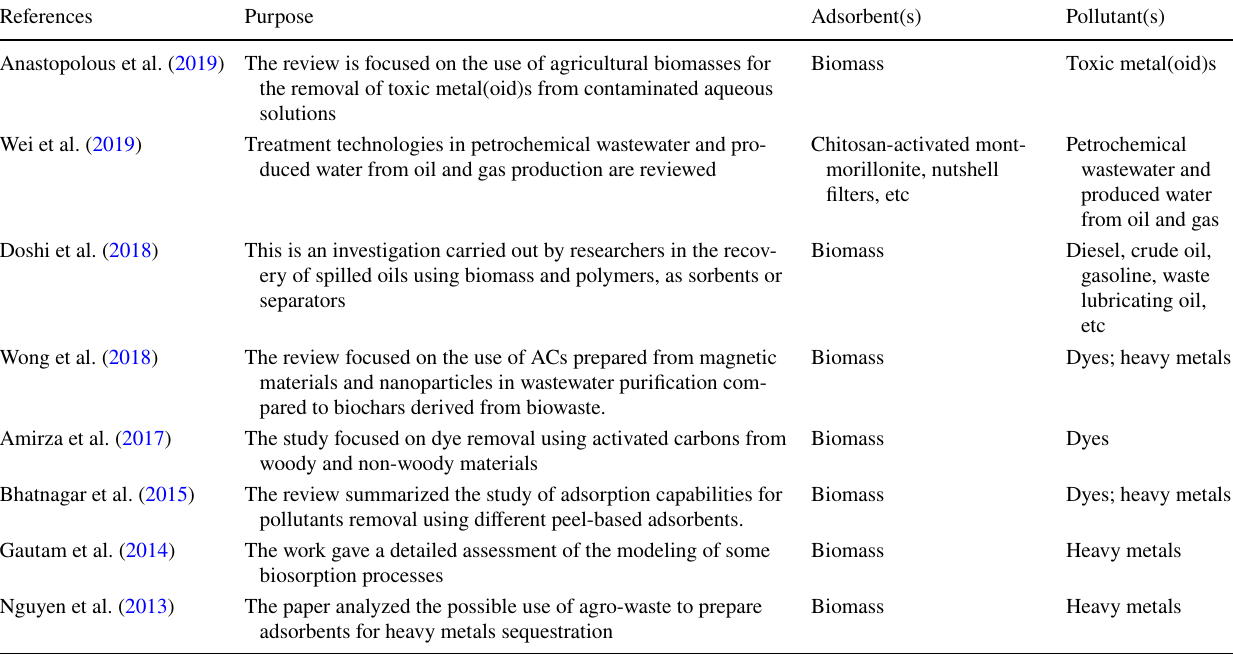
Table 1 Some review articles concerning wastewater decontamination by economical adsorbents published in